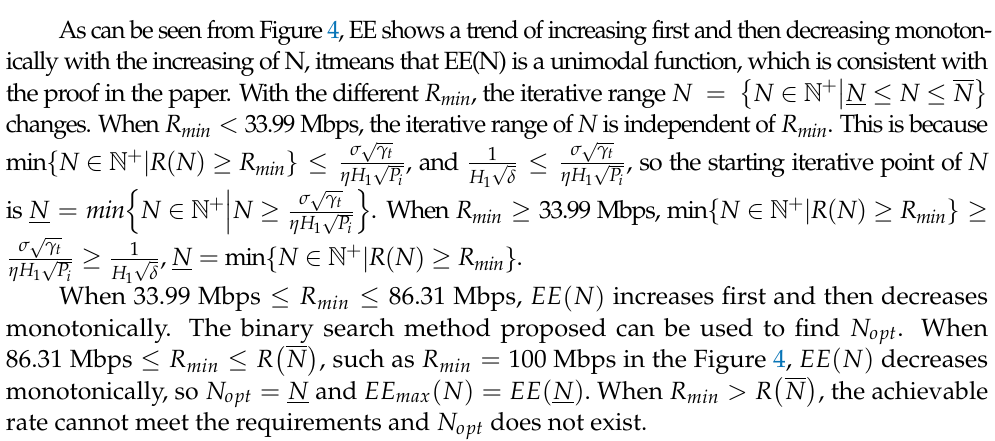
Figure 4. EE versus N with different R min